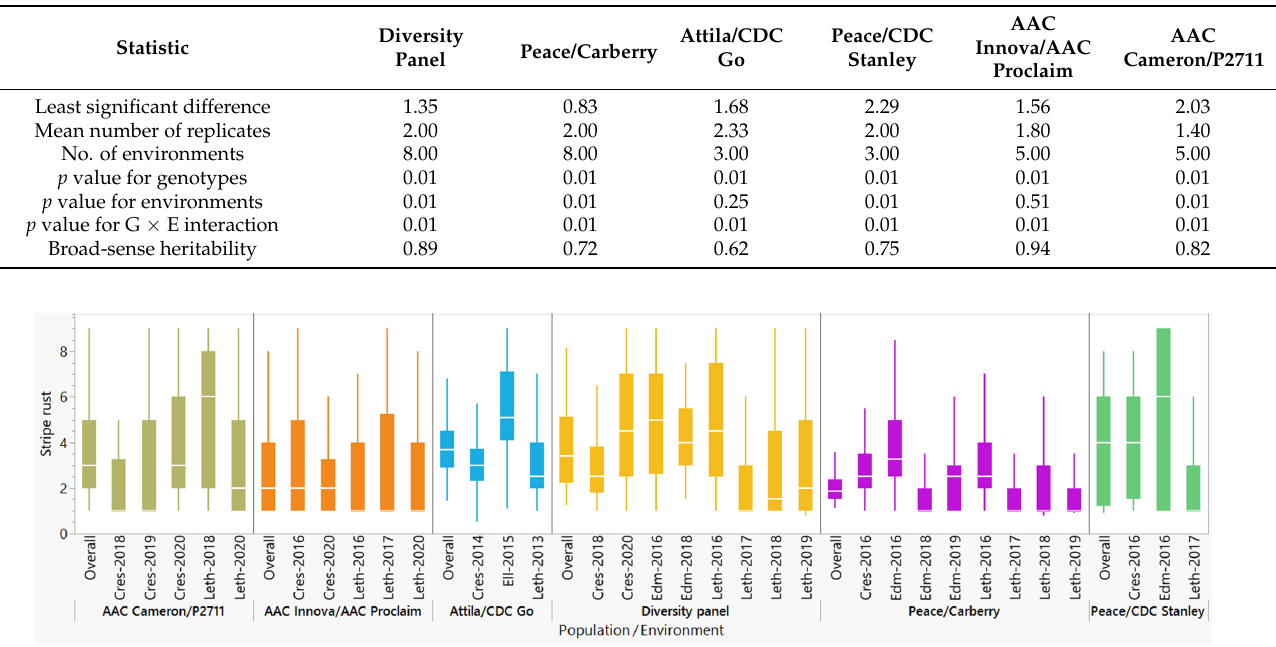
Figure 1. Comparison of reaction to stripe rust recorded in six spring wheat populations evaluated across all three to eight field environments (overall) and each environment. The individual environ- ment starts with a prefix representing location (Cres: Creston, Leth: Lethbridge, Edm: Edmonton, Ell: Ellerslie), followed by the year of the trial. Table 1. Summary statistics of variance component analyses and broad ‐ sense heritability of stripe rust in six spring wheat populations evaluated at three to eight field environments.